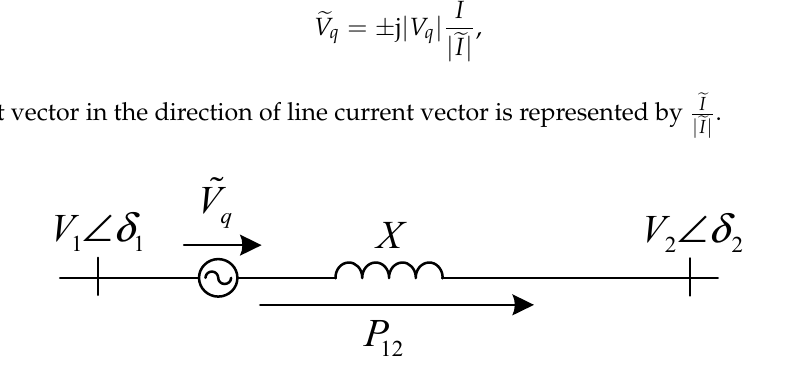
Figure 4. Circuit model of a transmission line with DPFC.